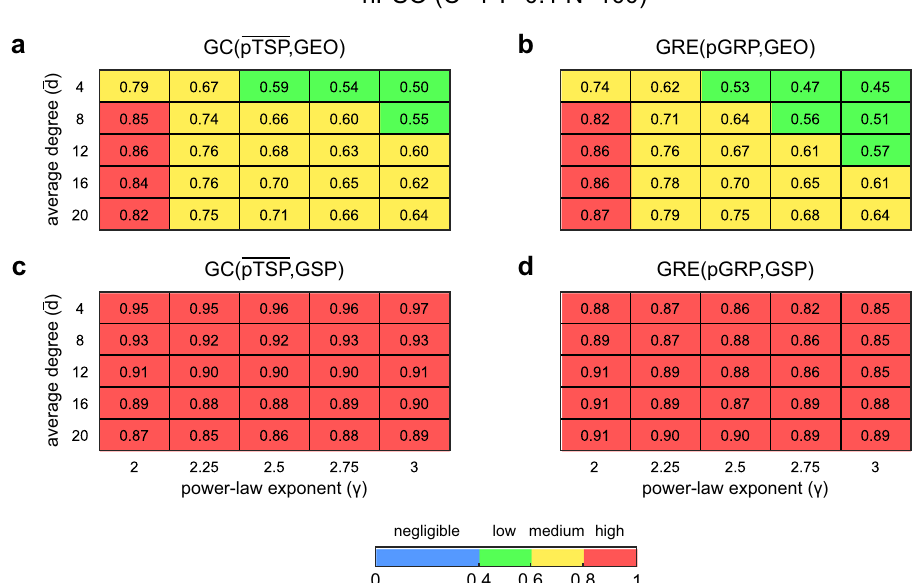
Fig. 3 | GC and GRE evaluation on hyperbolic networks. nPSO networks have been generated with parameters N = 100, (cid:1) d = [4, 8, 12, 16, 20], T = 0.1, γ = [2, 2.25, 2.5, 2.75, 3] and C = 4. For each combination of parameters, 10 networks have been generated. For each network we have computed: ( a ) GC(pTSP,